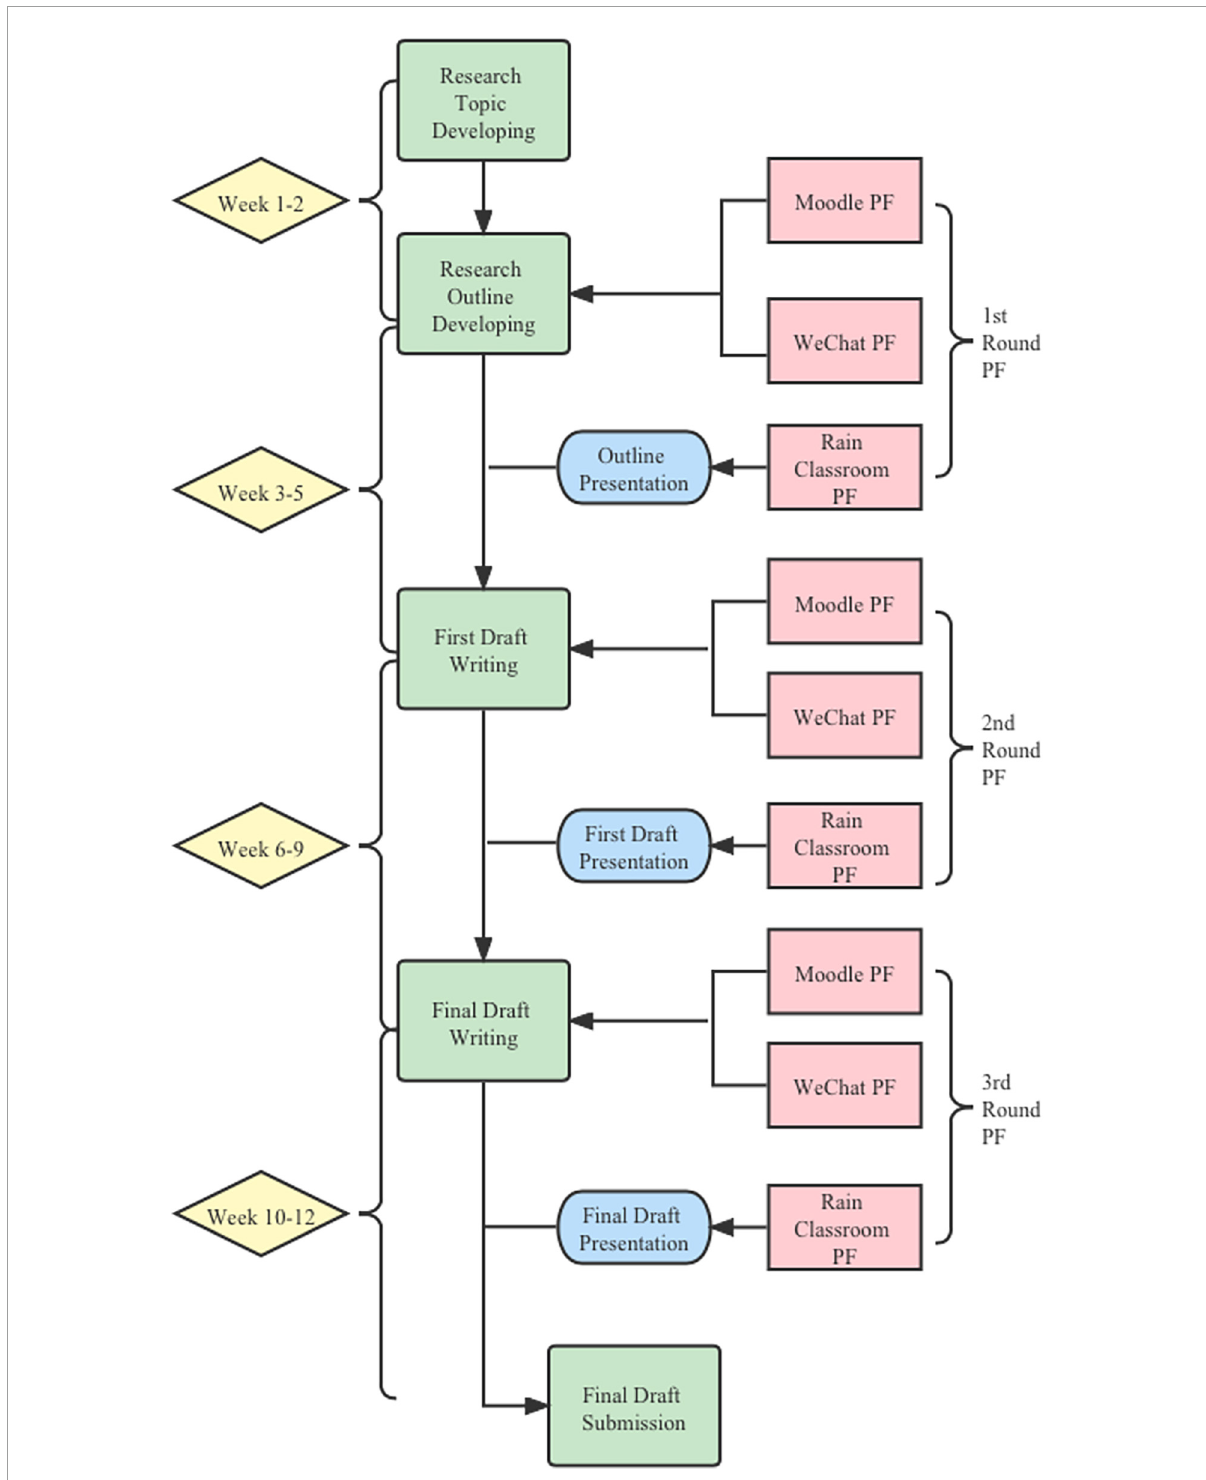
FIGURE1 The course